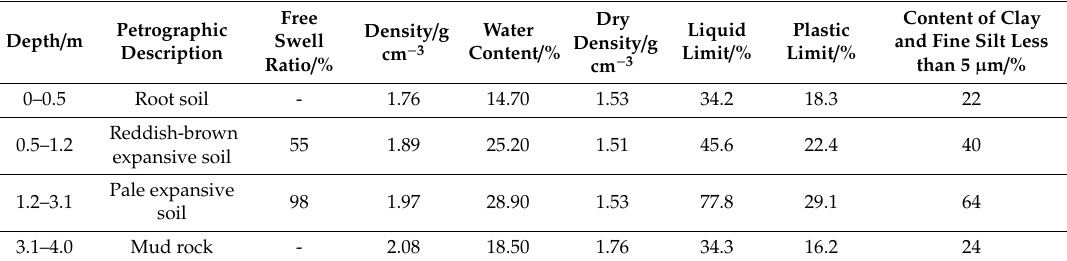
Table 1. Physical and mechanical properties of soil.